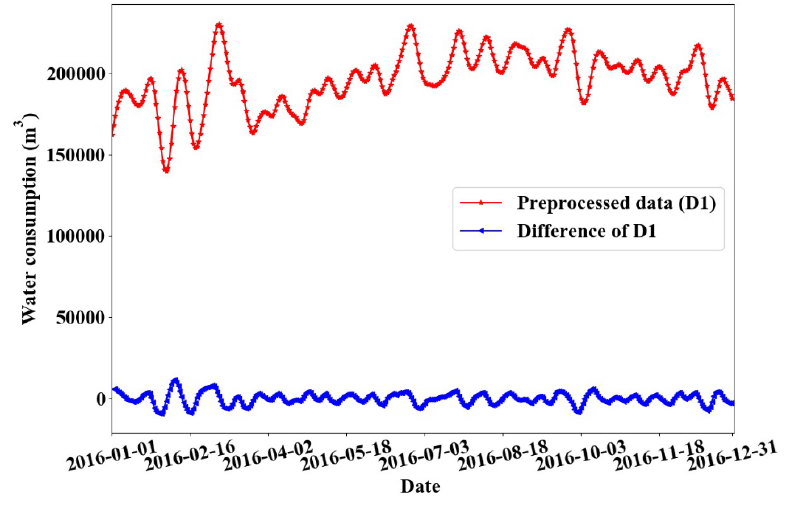
Figure 8. The original and first-order difference of total water consumption at monitoring point 2.